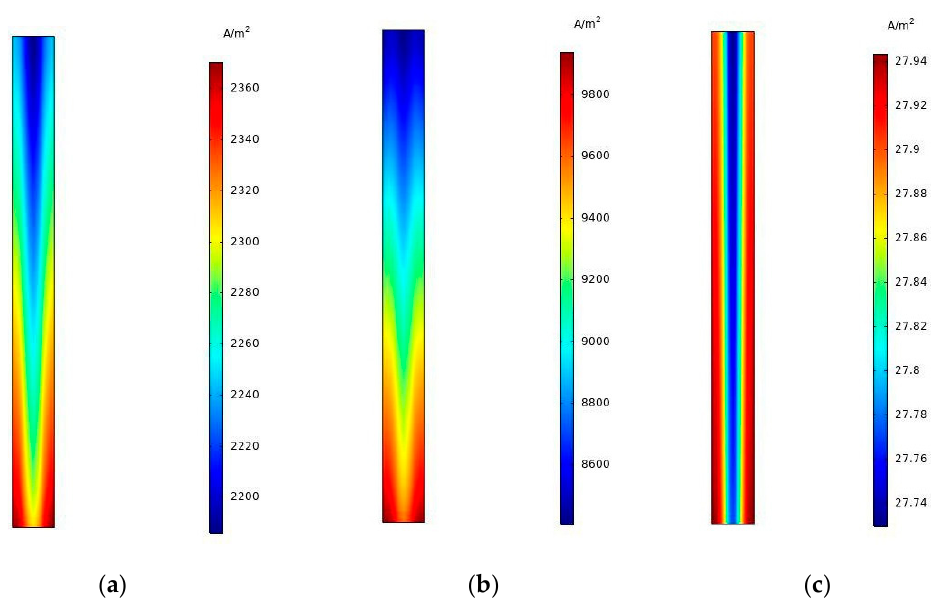
Figure 11. Current density distribution on membrane surface at 180 °C and ( a ) 0.3 V, ( b ) 0.6 V, ( c ) 0.9 V.